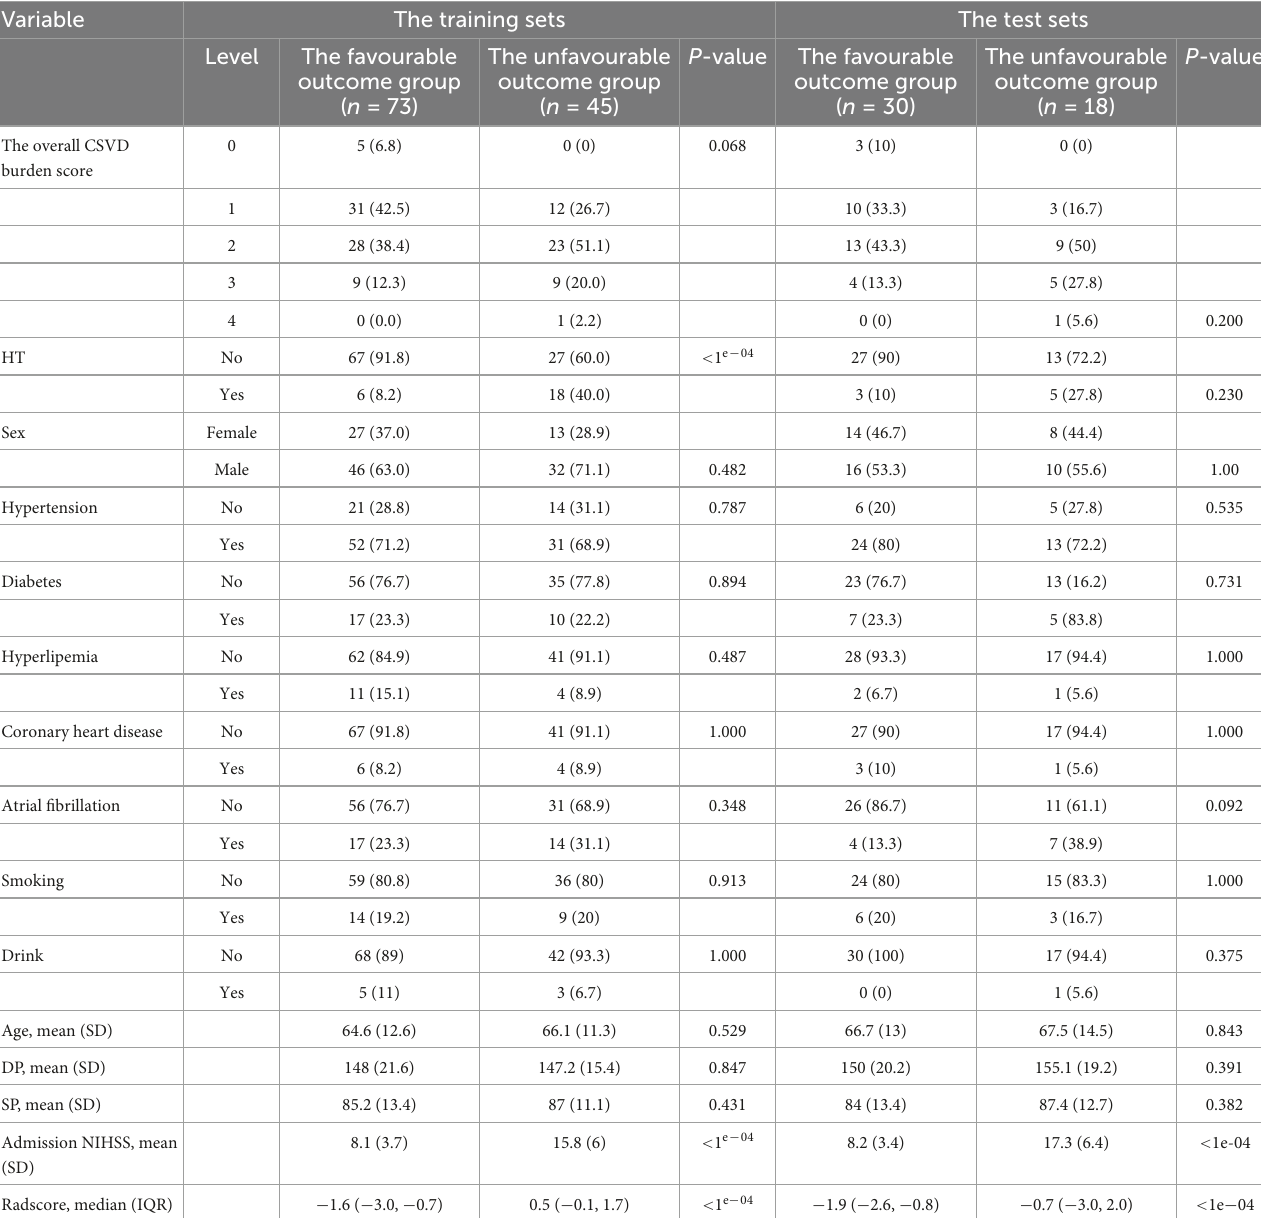
TABLE 1 Patient features in the training sets and test